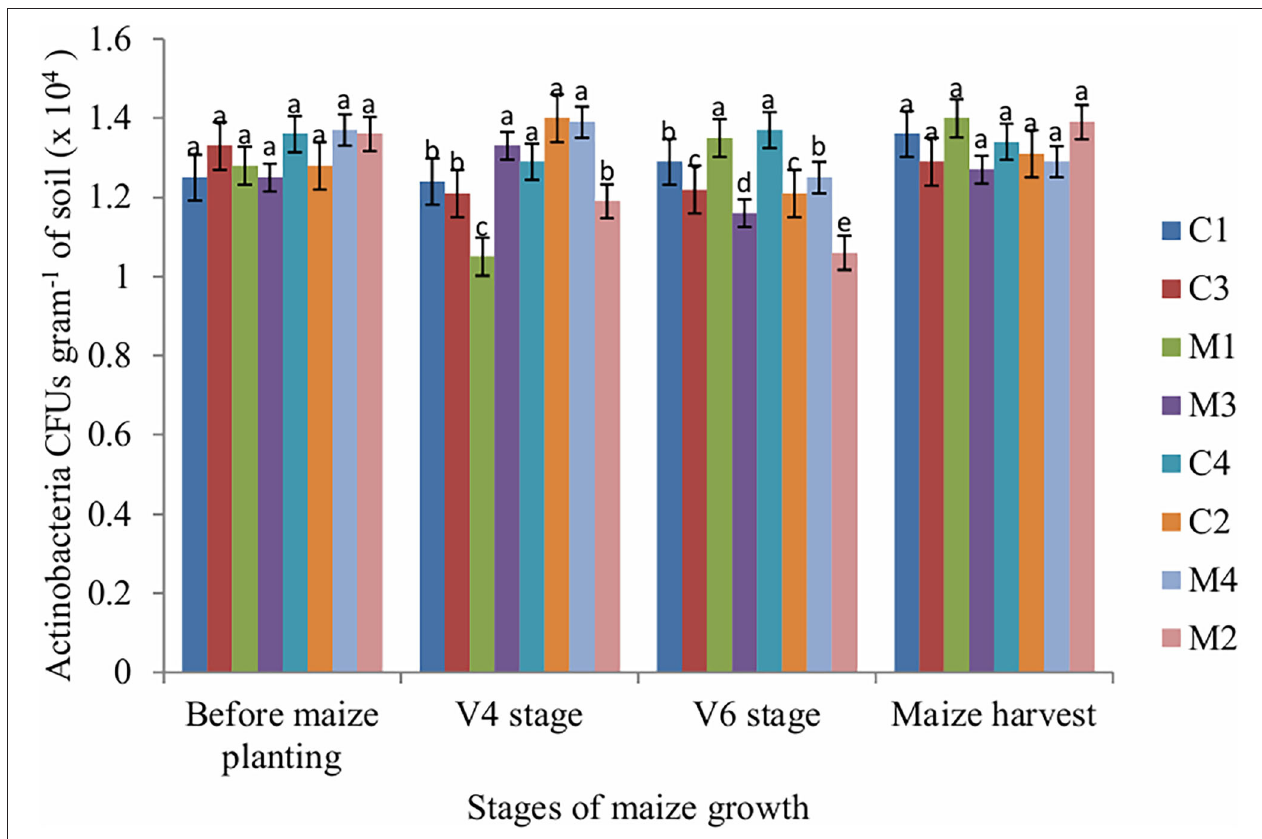
FIGURE 3 | Actinobacteria CFUs as influenced by tillage, mulching and inorganic fertilization. Stages of maize growth were; before maize planting: 0 days, V4 stage: 22 days, V6 stage: 63 days, and maize harvest stage: 147 days. Vertical bars represent means and whiskers – standard